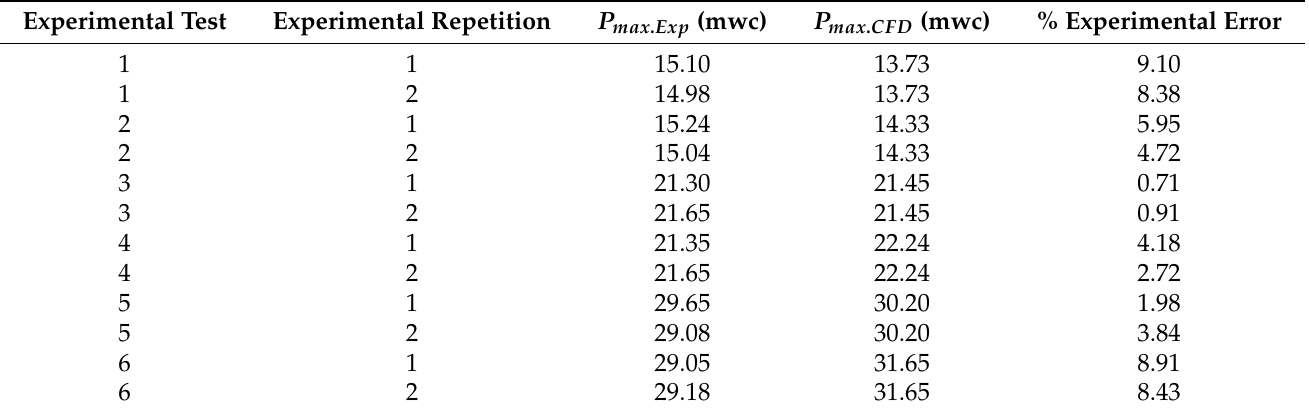
Table 3. Results of the CFD model P max CFD vs. Experimental data P max